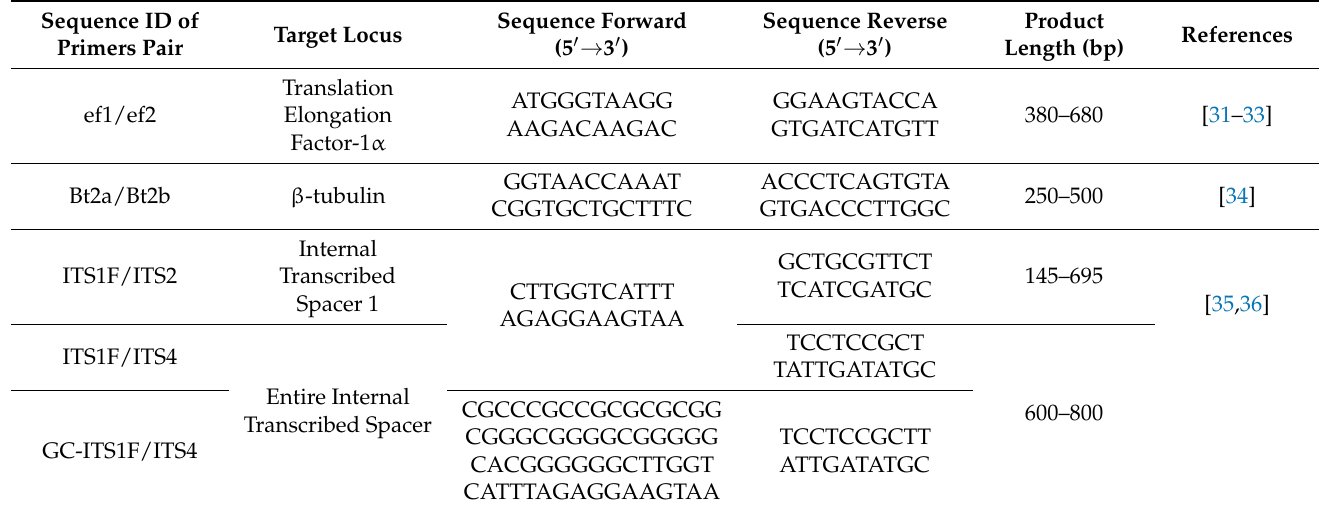
Table 2. PCR primers sequences (forward and reverse) used for fungal strains